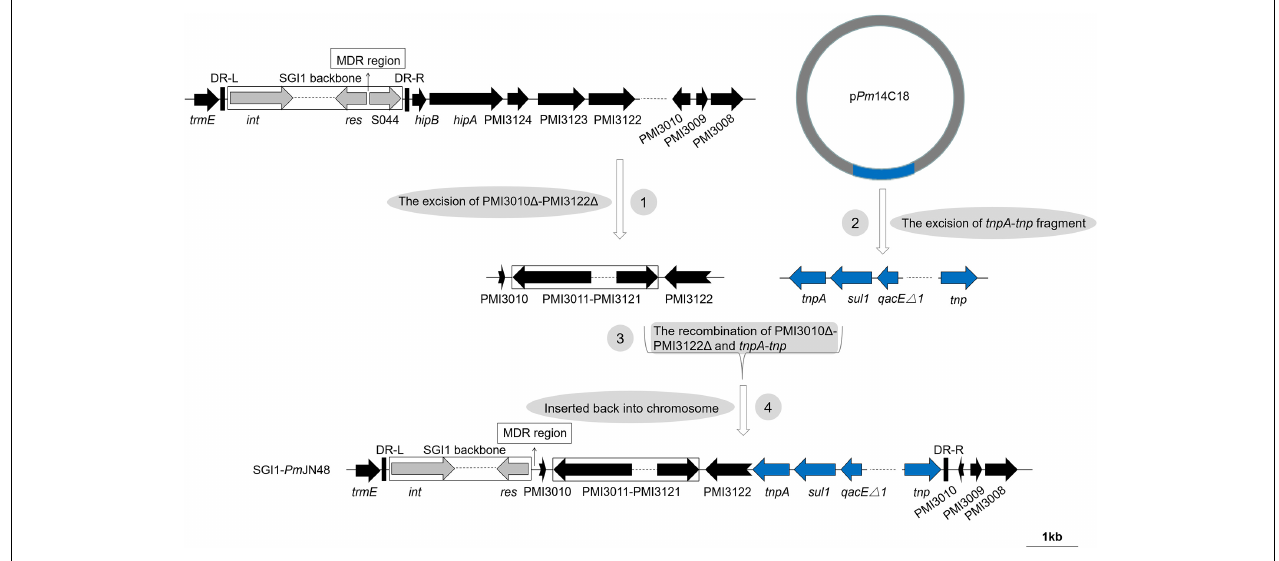
FIGURE 3 | The four-step pathway for the generation of SGI1- Pm JN48. SGI1- Pm JN48 backbone was shown with different colored arrows: conserved SGI1 backbone (gray), chromosomal DNA of P. mirabilis (black), tnpA-tnp fragment of plasmid p Pm 14C18 (blue). The direct repeats of SGI1 (DR-L/DR-R) and the position of the MDR regions are indicated by thick vertical bars and thin arrows, respectively. Truncated genes are shown by swallowtail